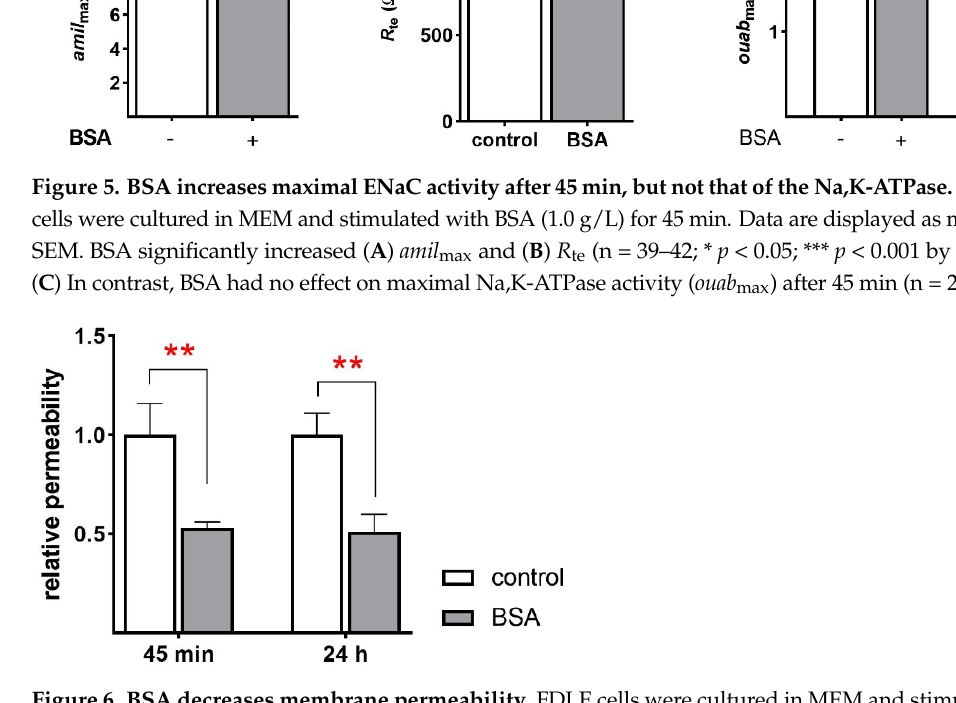
Figure 5. BSA increases maximal ENaC activity after 45 min, but not that of the Na,K-ATPase. FDLE cells were cultured in MEM and stimulated with BSA (1.0 g/L) for 45 min. Data are displayed as mean + SEM. BSA significantly increased ( A ) amil max and ( B ) R te (n = 39–42; * p < 0.05; *** p < 0.001 by t -test). ( C ) In contrast, BSA had no effect on maximal Na,K-ATPase activity ( ouab max ) after 45 min (n = 27–31).